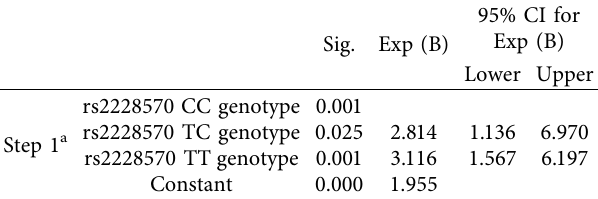
Table 6: Logistic regression analysis-based odds ratios of the significance of genotypes of rs2228570 with the caries